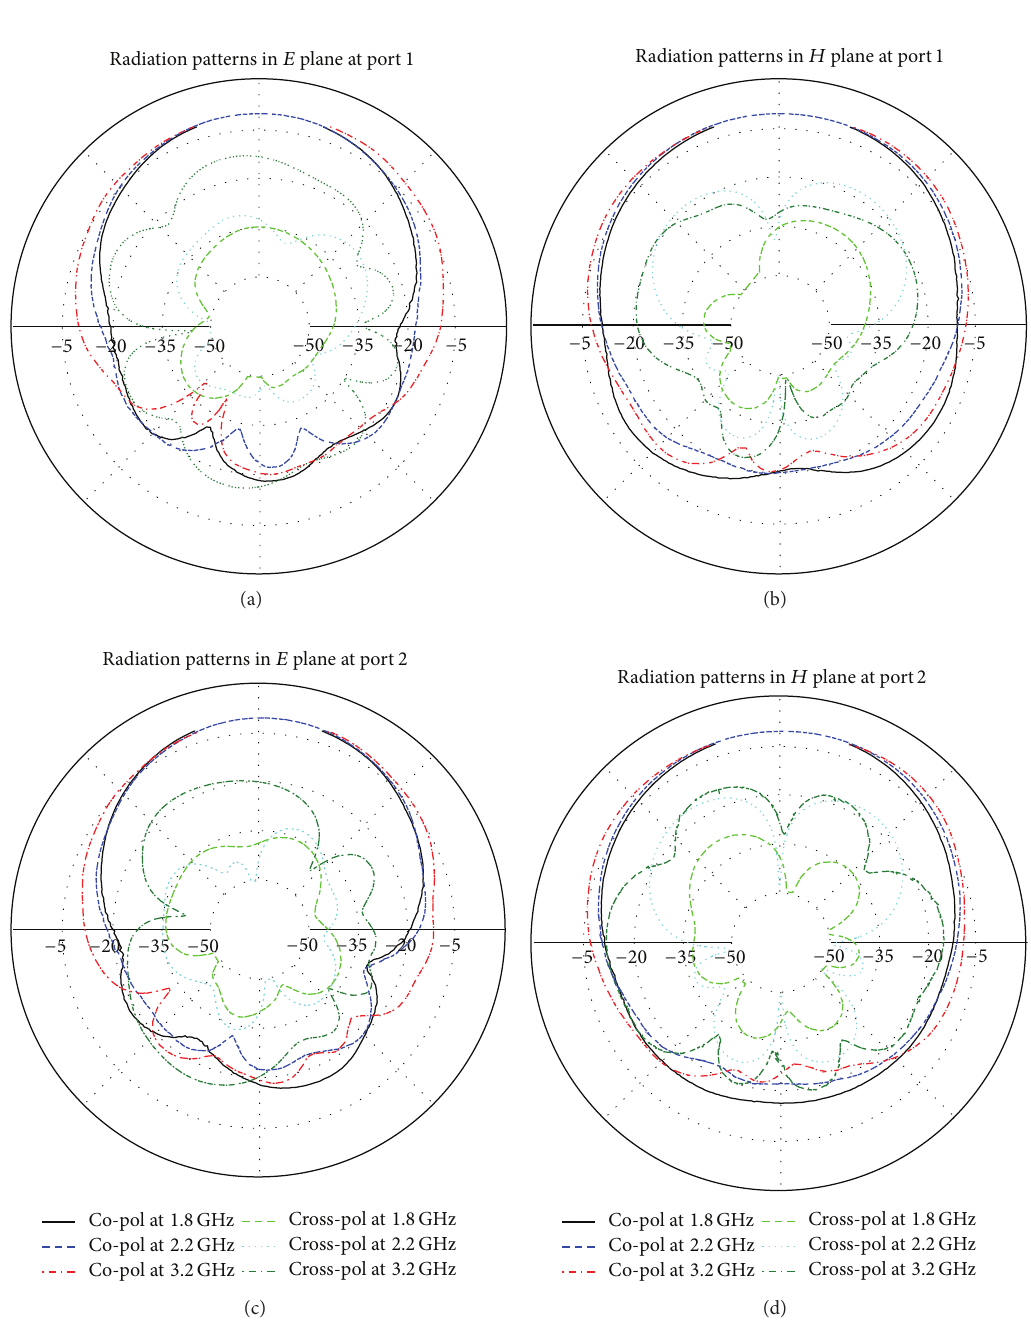
Figure 9: Measured radiation patterns at 1.8 GHz, 2.2 GHz, and 3